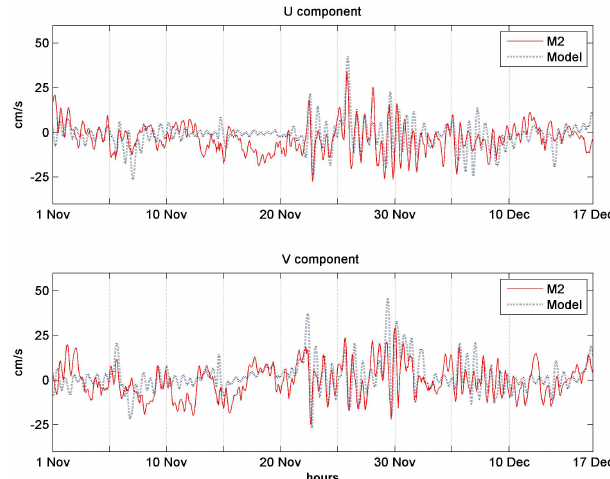
Fig. 16. Comparison of simulated and second mode surface cur- rents: daily mean u and v component.